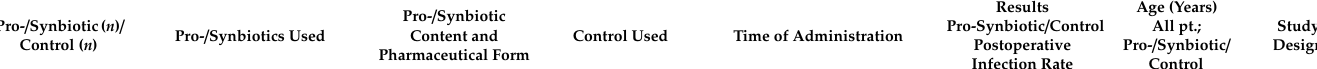
Table 1. Studies on perioperative pro- / synbiotics and their e ff ect on postoperative